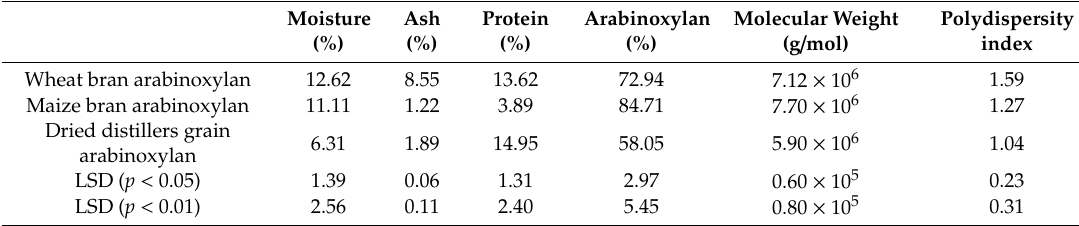
Table 1. Proximate compositions (dry weight basis) of alkaline extracted wheat bran arabinoxylan, maize bran arabinoxylan, and dried distillers grain arabinoxylan.